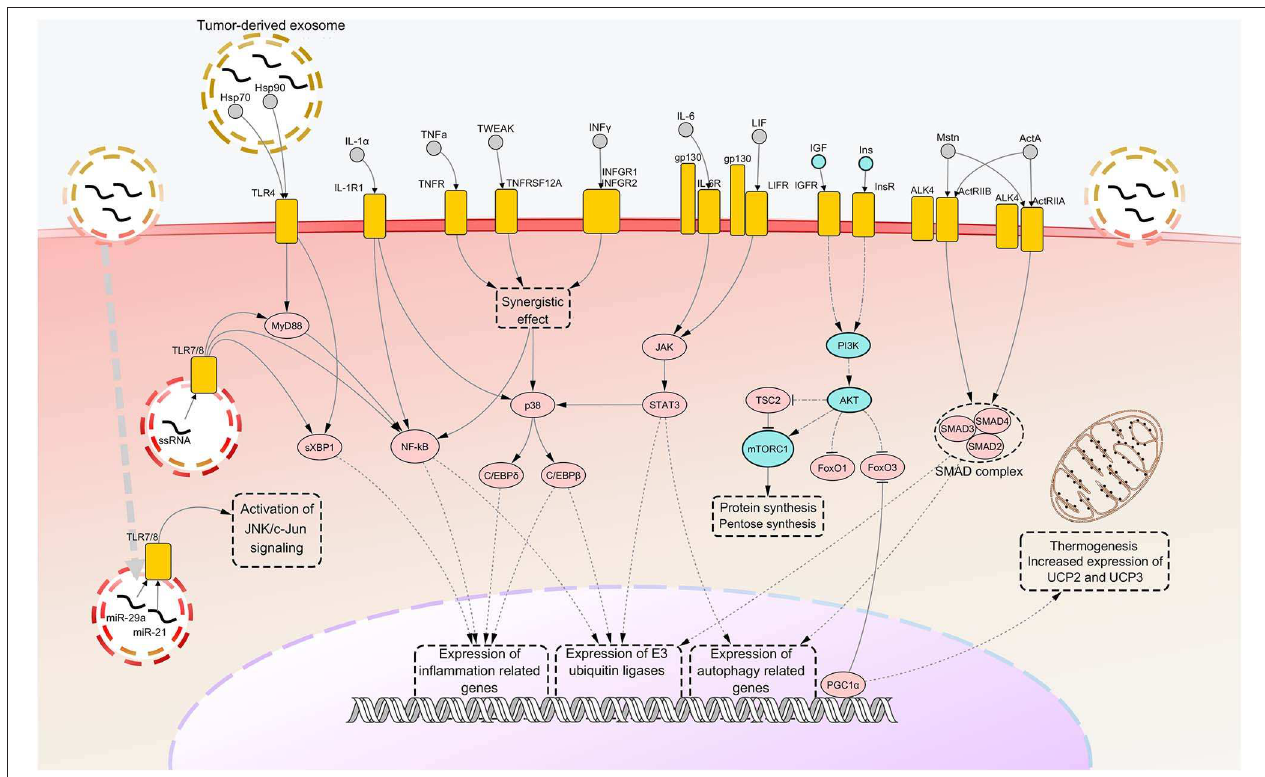
FIGURE 1 | Notorious molecular mechanisms underlying skeletal muscle wasting during cancer cachexia. Atrophy of skeletal muscle in cancer cachexia is due to aberrant activation of specific signaling pathways, consequent to the binding of factors secreted by the tumor, the stroma or the immune system to their cognate receptors. Most of such signaling pathways converge toward activation of selective transcription factors, causing their nuclear translocation and binding to promoters of cachexigenic genes. These include genes encoding cytokines [e.g., tumor necrosis factor alpha (TNF α ) and interleukin 6 (IL-6)], inflammation-related receptors [e.g., toll-like receptor 4 (TLR4) and TLR7], myokines [e.g., myostatin (Mstn)], muscle-specific E3 ubiquitin ligases and autophagy-related proteins. Such events potentiate inflammatory processes at the local level and cause the breakdown of myofibrillar proteins, impairing the contractile function of skeletal muscles. Several cachexia-inducing factors are known to exert their cachectigenic effect by acting synergistically, as in the case of TNF α and interferon gamma (INF γ ). To the contrary, downregulation occurring in the insulin (Ins) and insulin growth-like factor (IGF) signaling determines a decrease in mTOR-dependent protein synthesis, due to upstream downregulation of RAC serine/threonine-protein kinase (AKT) activity. In normal conditions, AKT functions also as a negative regulator of forkhead box protein O1 (FoxO1) and FoxO3 transcription factors, preventing their nuclear translocation. Thus, consequent to AKT downregulation under cachectic conditions, both these FoxOs localize into the myonucleus and induce transcription of autophagy components and muscle-specific E3 ubiquitin ligases. Peroxisome-proliferator-activated receptor-gamma co-activator 1-alpha (PGC1 α ), overexpressed during cancer cachexia, is known to inhibit FoxO3 binding to the DNA and cause enhance expression of genes involved in energy metabolism and mitochondrial biogenesis. Upregulated nodes are colored in pink and connected with other nodes through continuous edges. Downregulated nodes are colored in azure and connected with other nodes through dash-dot edges. Dashed edges represent connections between transcriptional/co-transcriptional factors and gene expression. ActA, activin A; ActIIR, activin type 2 receptor; ALK4, activin receptor type-1B; C/EBP, CCAAT/enhancer binding protein; c-Jun, proto-oncogene c-Jun; Gp130, glycoprotein 130; Hsp, heat shock protein; IL-1a, interleukin 1 alpha; IL-1R1, interleukin 1 receptor 1; IL-6R, IL-6 receptor; INFGR, INF γ receptor; JAK, Janus kinase; JNK, c-Jun N-terminal kinase; LIF, leukemia inhibitory factor; LIFR, LIF receptor; miR, microRNA; mTORC1, mammalian target of rapamycin complex 1; MyD88, myeloid differentiation factor 88; NF-kB, nuclear transcription factor kappa B; p38, p38 mitogen-activated protein kinase; PI3K, Phosphoinositide 3-kinase; SMAD, small mother against decapentaplegic; STAT3, signal transducer and activator of transcription 3; sXBP1, spliced isoform X-box-binding protein 1; TNFR, tumor necrosis factor receptor; TNFRSF12A, TNF Receptor Superfamily Member 12A; TSC2, tuberous sclerosis complex 2; TWEAK, TNF-related weak inducer of apoptosis; UCP, uncoupling